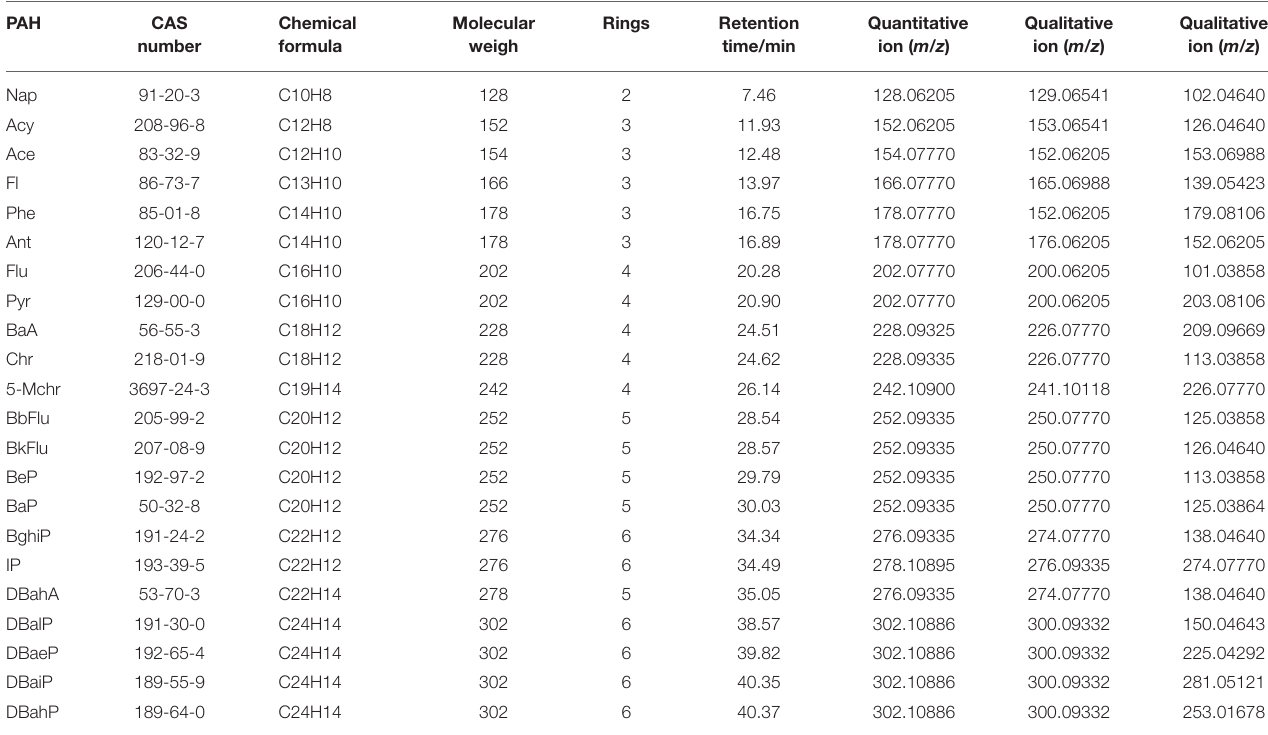
TABLE 1 | Formula, Retention time and Mass spectrometric of the 22